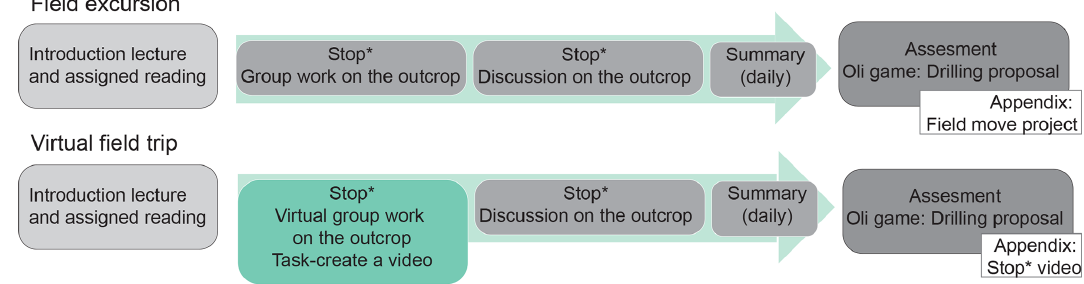
Figure 11. Consequences of the Covid-19 pandemic on the AG222 assessment related to the license claim